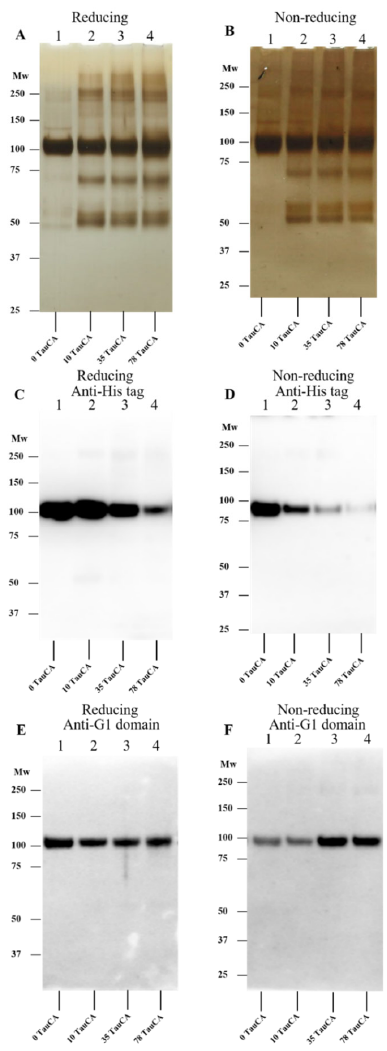
Figure 6. Effects of different concentrations of TauCA on rhAggrecan. Preformed chloramines (see Section 2) were incubated, at the indicated molar excesses with rhAggrecan (643 nM) for 24 h at 37 °C in buffer A, before examination by SDS ‐ PAGE with subsequent silver staining (panel A , reducing conditions; panel B : nonreducing condition) and Western blotting (panels C – F ) by using an anti ‐ His ‐ tag (C ‐ terminus) antibody (panels C , D : reducing and nonreducing gels, respectively) and an anti ‐ G1 domain antibody (panel E : reducing, panel F : nonreducing). For further details, see Section 2 and the legend to Figure 3. Representative images from three independent experiments are presented. Molecular mass markers are indicated on the left of each image.